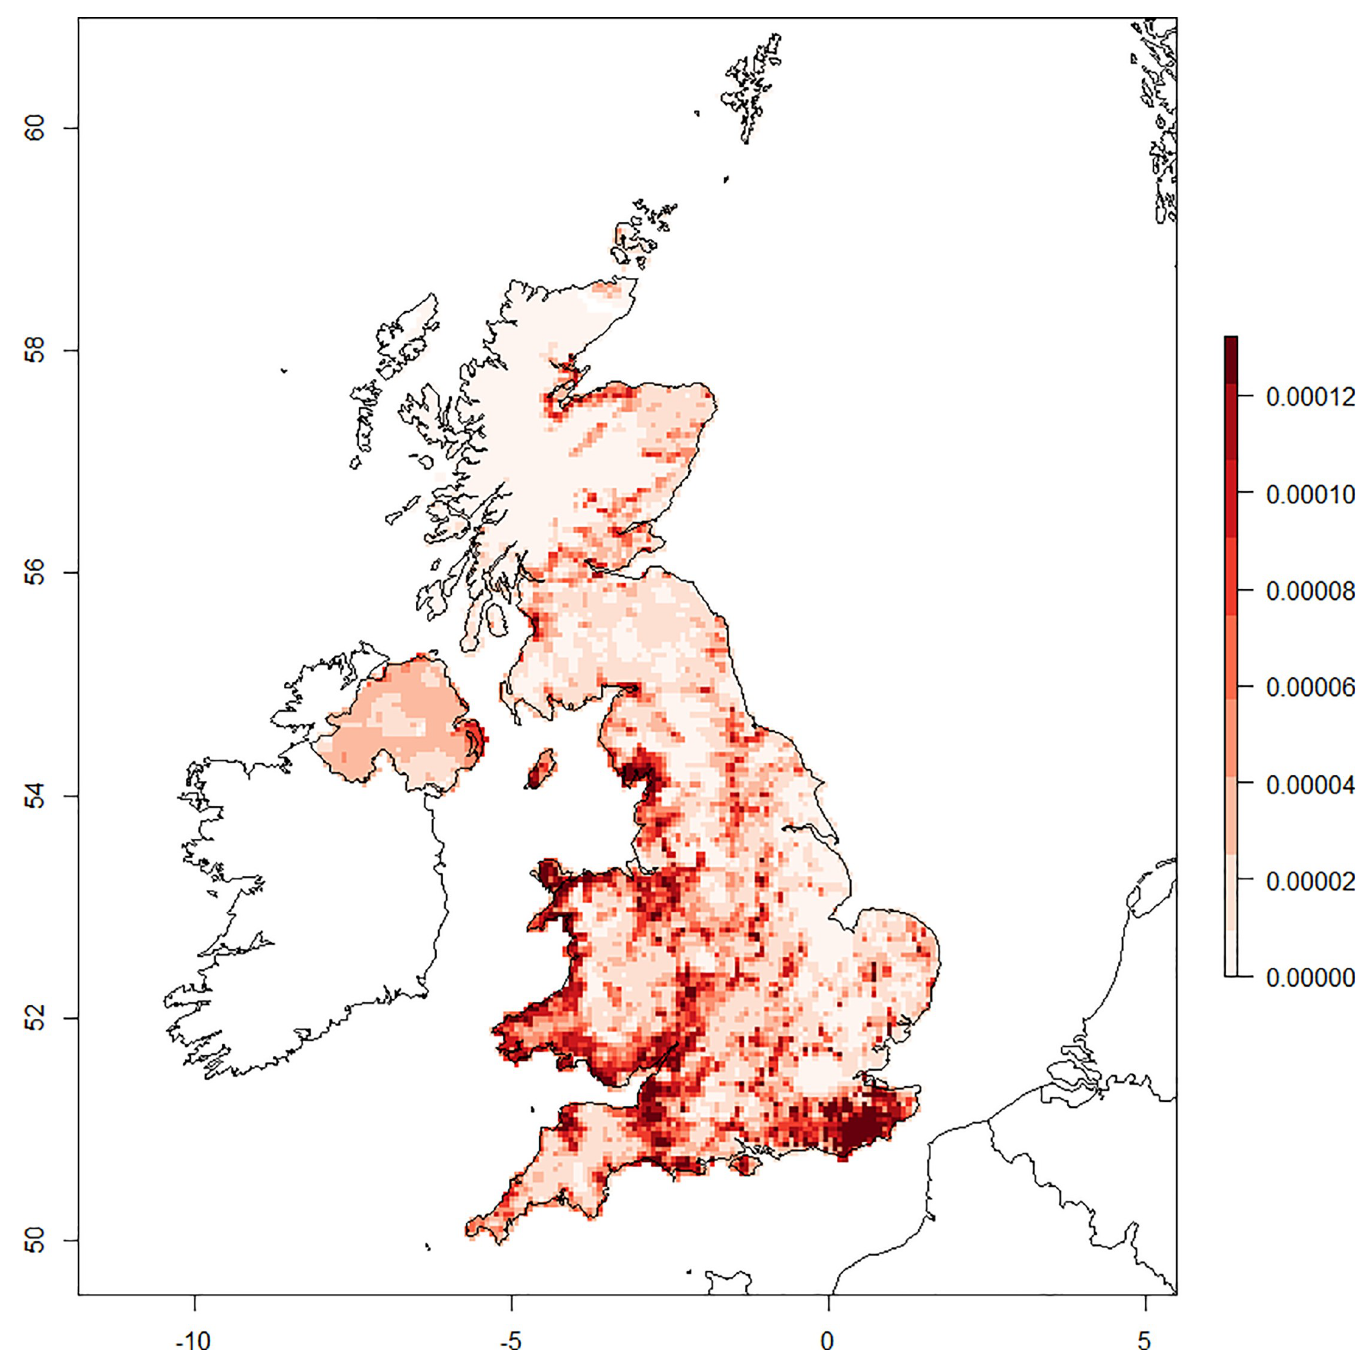
Fig 3. Risk of establishment of RVF. Higher values (darker shade) indicate higher relative probability of establishment in UK, given entry of RVF has